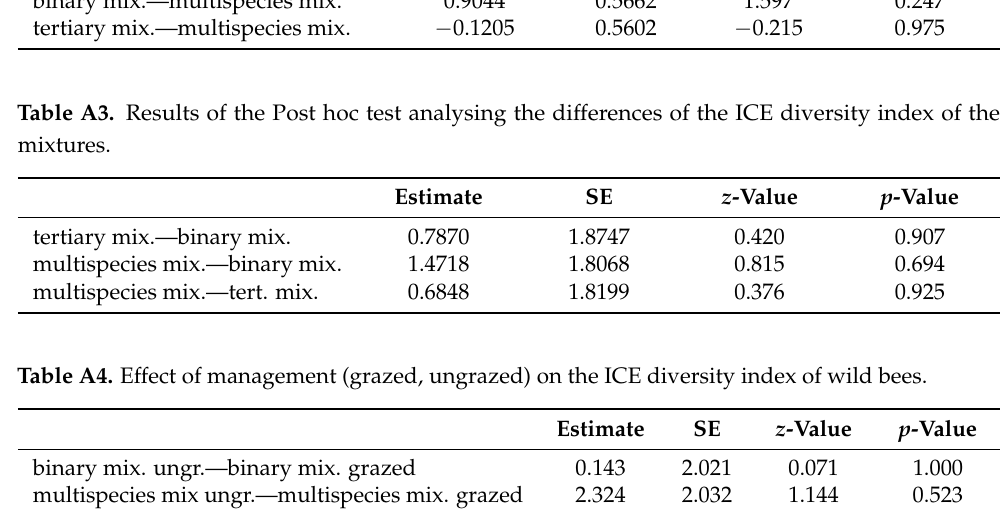
Table A2. Results of the Post hoc test analysing the differences of wild bee abundance of the mixtures. Estimate SE z -Value p -Value binary mix.—tertiary mixture 1.0248 binary mix.—multispecies mix. tertiary mix.—multispecies mix.